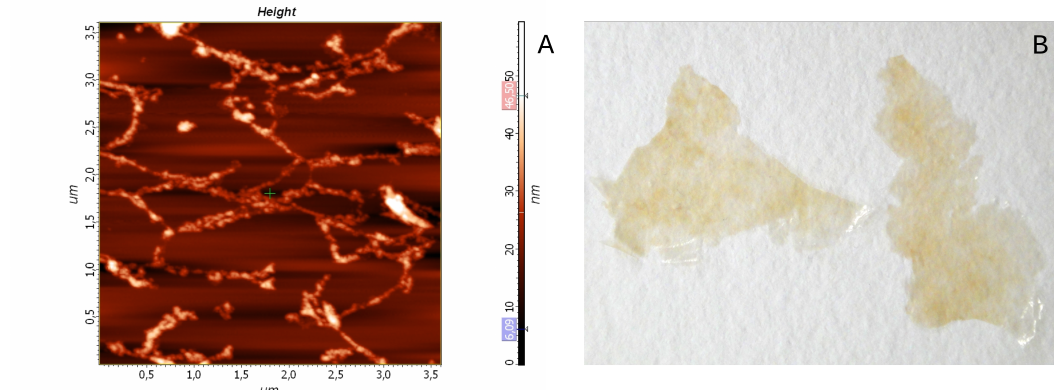
Figure 6. The atomic force microscopy (AFM) image of pseudofibrils, forming the “thin” film obtained by drying the MCC washout on the mica surface ( A ). The “thick” film obtained by 30-fold repeating the supernatant drying operation ( B